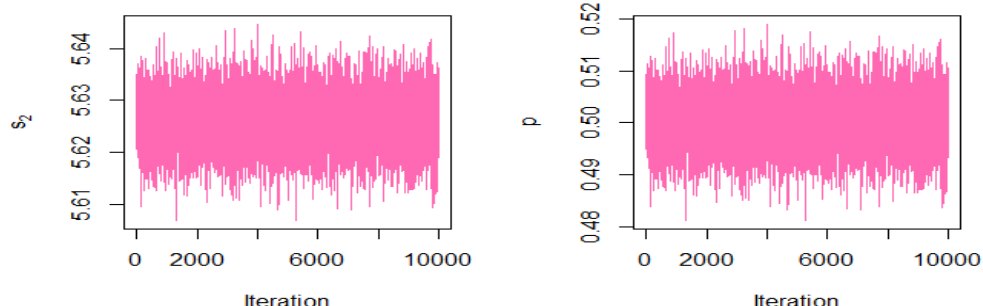
Figure 4. MCMC trace for results of Bayesian estimation of model for complete Bladder data for first 9 parameters.